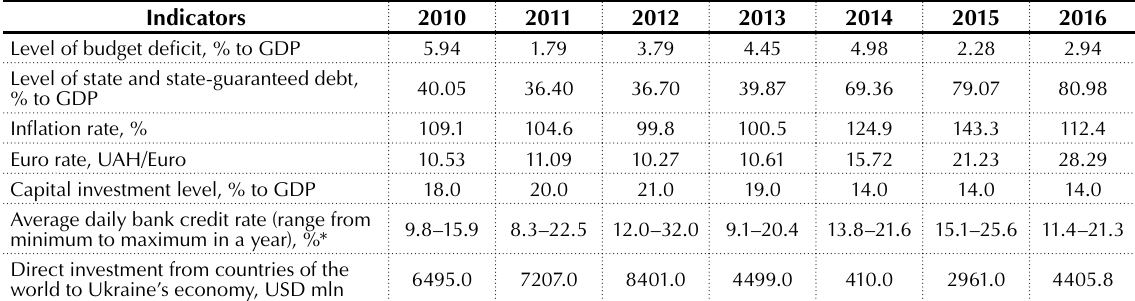
Table 5. Indicators of financial and investment activity Source: calculated according to Діяльність суб’єктів господарювання (2015) [Diialnist subiektiv hospodariuvannia (2015)], Діяльність суб’єктів господарювання [Diialnist subiektiv hospodariuvannia (2011)], Прямі інвестиції (акціонерний капітал) з країн світу в економіку України [Priami